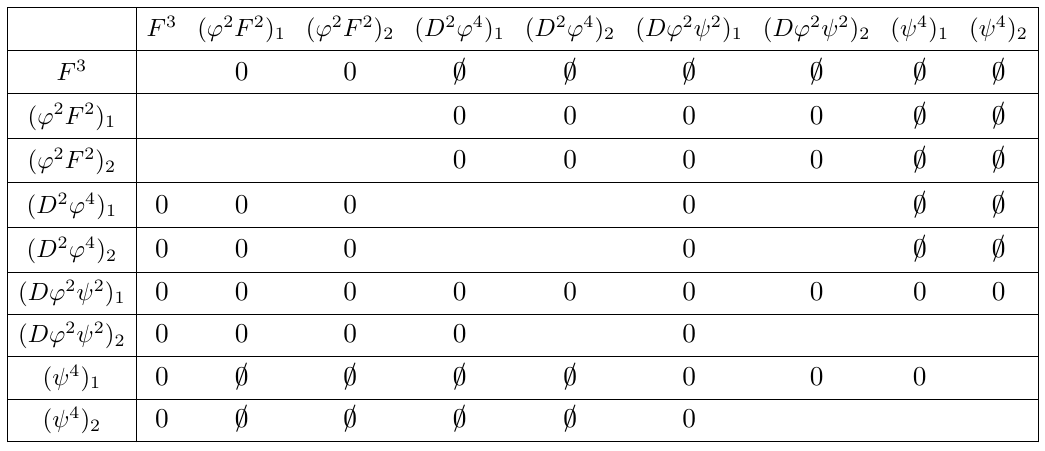
Table 2 . Structure of the zeros in the one-loop anomalous dimension matrix. The = 0 entries indicate there are no contributing one-loop diagrams, whereas a 0 alone indicates that there are one-loop diagrams that could contribute, but actually give a vanishing result. The operators labeling the rows are renormalized by the operators labeling the